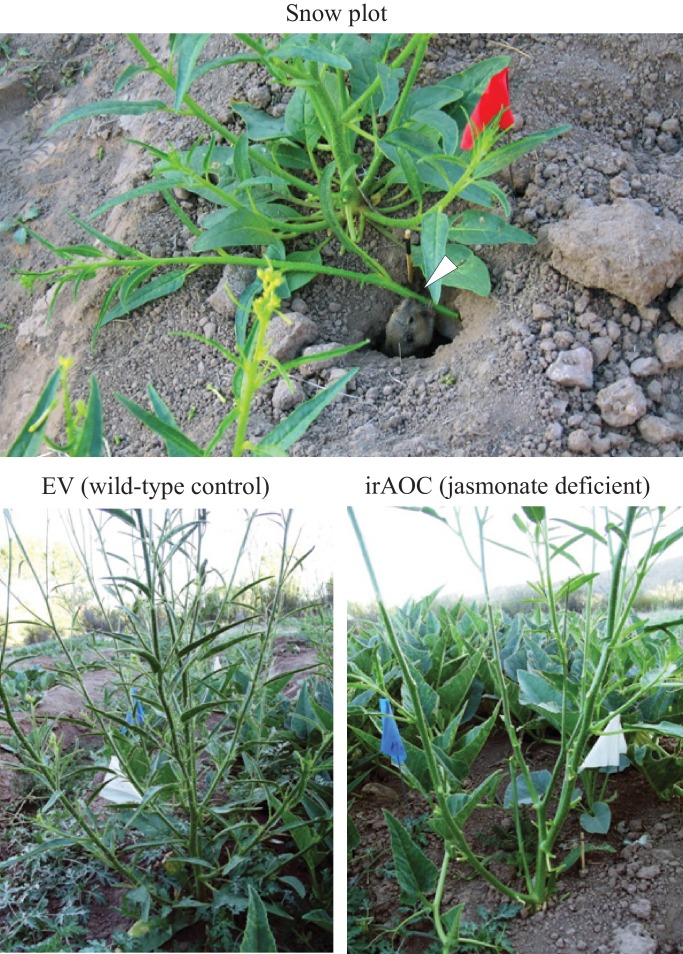
Photographic evidence of herbivore damage and the associated herbivores in the Snow plot.Several gophers were observed within the snow plot (Top, white arrow). Bottom left: Typical EV plant in the snow plot. Bottom right: IrAOC plant that was partially defoliated by animal browsing. Gopher picture by Arne Weinhold.